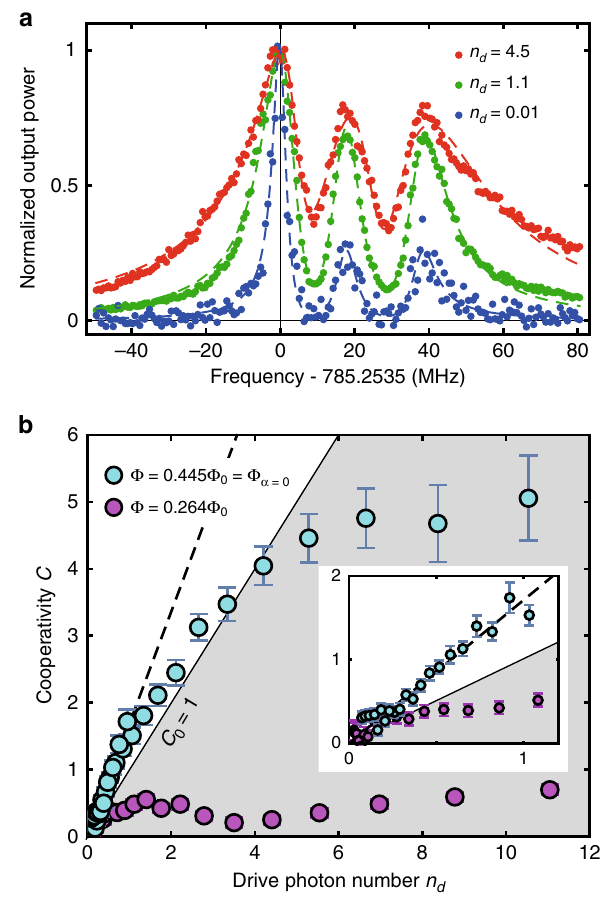
Fig. 3 Strong arti fi cial radiation pressure. a Normalized output power of the MW signal coherently up-converted from the SAW excitations as a function of the detuning of the SAW drive frequency (dots). Three datasets are for different drive powers represented by the average number, n d , of drive photons in the MW resonator. Dashed curves are the results of fi ttings with a sum of three Lorentzians in the complex plane. The left-most peak is from the fundamental transverse mode of the SAW resonator, while the two other peaks are due to higher-index transverse modes. b Cooperativity C as a function of the drive photon number n d . White area corresponds to the single-photon quantum regime, i.e., C 0 > 1. Cyan dots are the experimental data at Φ = 0.445 Φ 0 = Φ α = 0 . Purple dots are taken at Φ = 0.264 Φ 0 , where α ≠ 0 and the saturation takes place at lower power. Black dashed line is the linear fi t for the cyan dots in the low-power region. Inset shows an enlarged view near the origin. Error bars represent standard